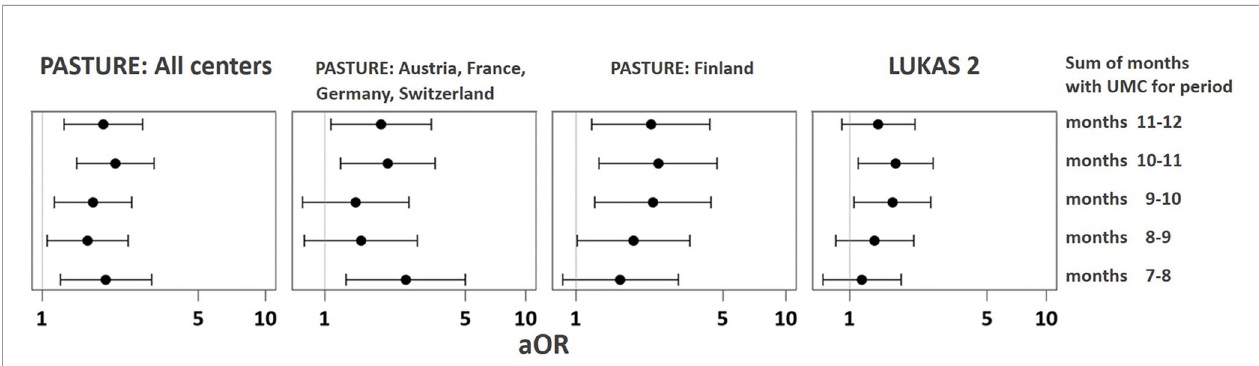
FIGURE 10 | Vulnerable window for the effect of UMC on asthma at age 6. UMC is coded as daily meat consumption without milk or yoghurt consumption at least on a weekly